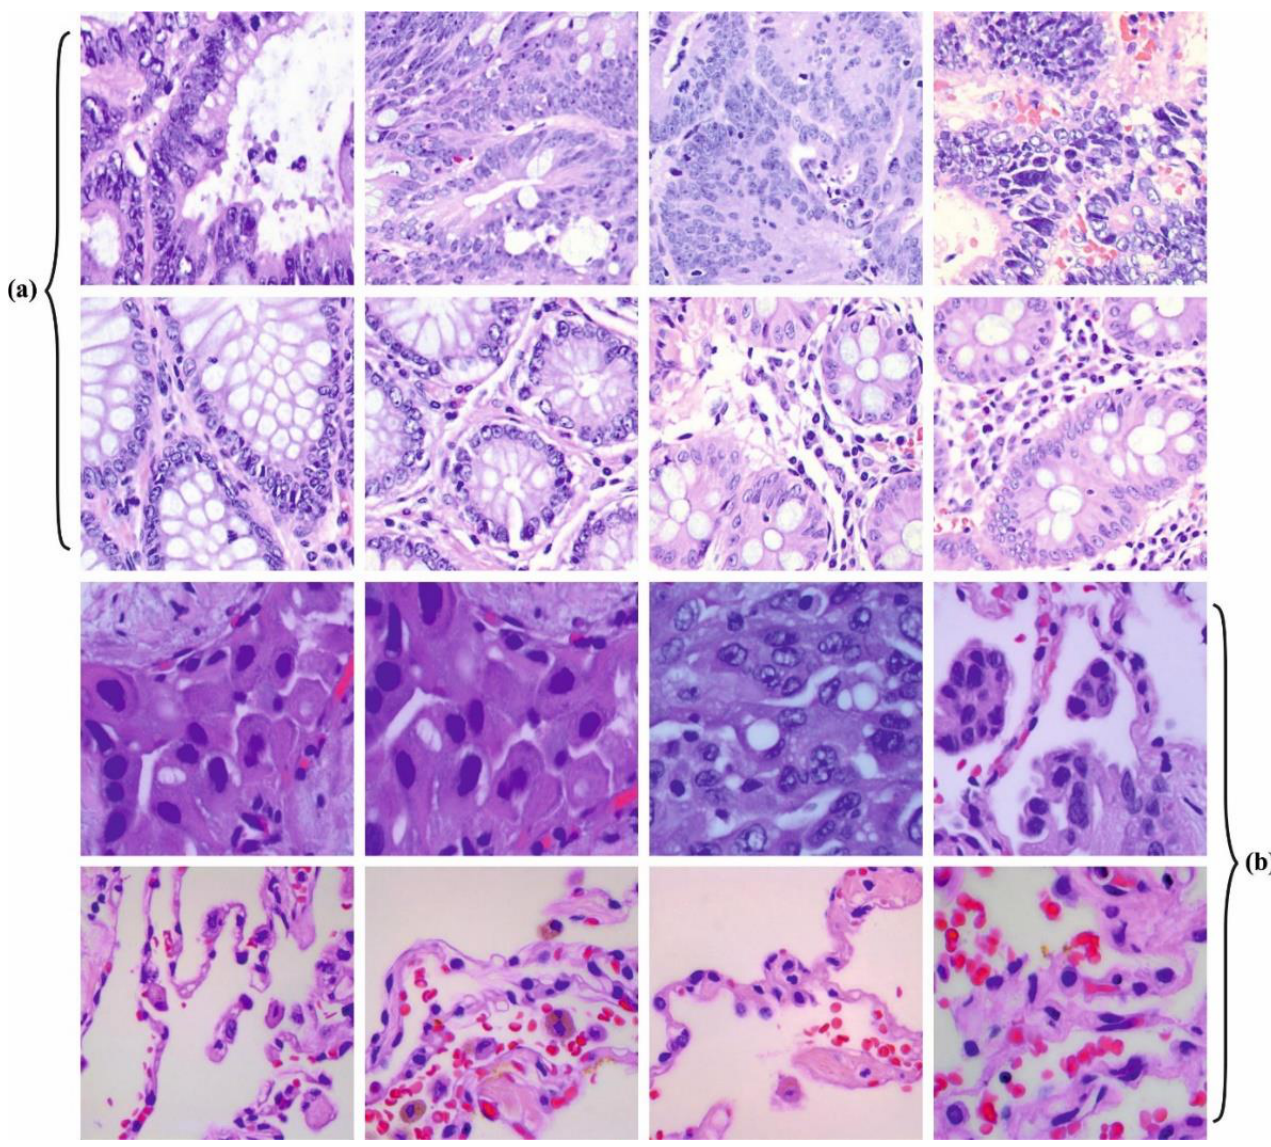
Figure 3. Sample Images: ( a ) Colon and ( b ) Lung.